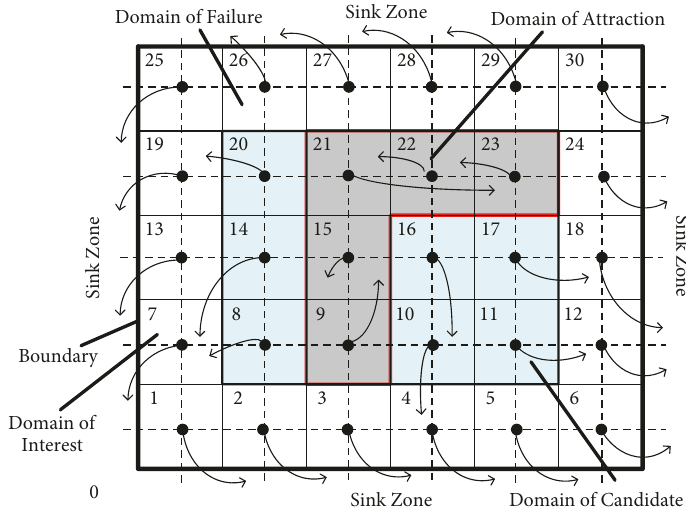
Figure 1: The domains in a two-dimensional